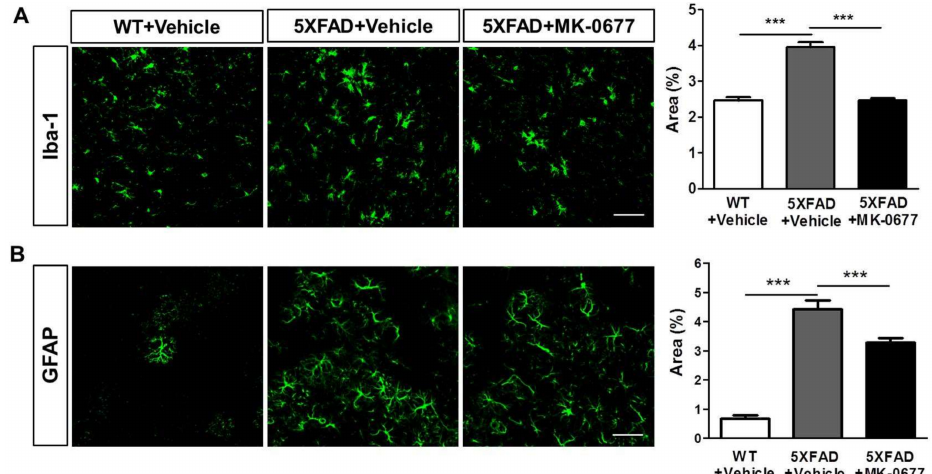
Figure 4. MK-0677-treated 5XFAD mice exhibited significant inhibition of neuroinflammation compared with vehicle-administered mice. Immunofluorescent staining was performed to detect the markers of microglia (Iba-1) and astrocyte (GFAP) in layer V of the frontal cortex of wild-type ( n = 8) and 5XFAD mice. MK-0677 significantly reduced the Iba-1 (+) area ( A ) and GFAP (+) area ( B ) in 5XFAD mice ( n = 6), compared with vehicle-treated 5XFAD mice ( n = 7). *** p < 0.001 indicates significant differences between the groups. Scale bar = 50 µ m.